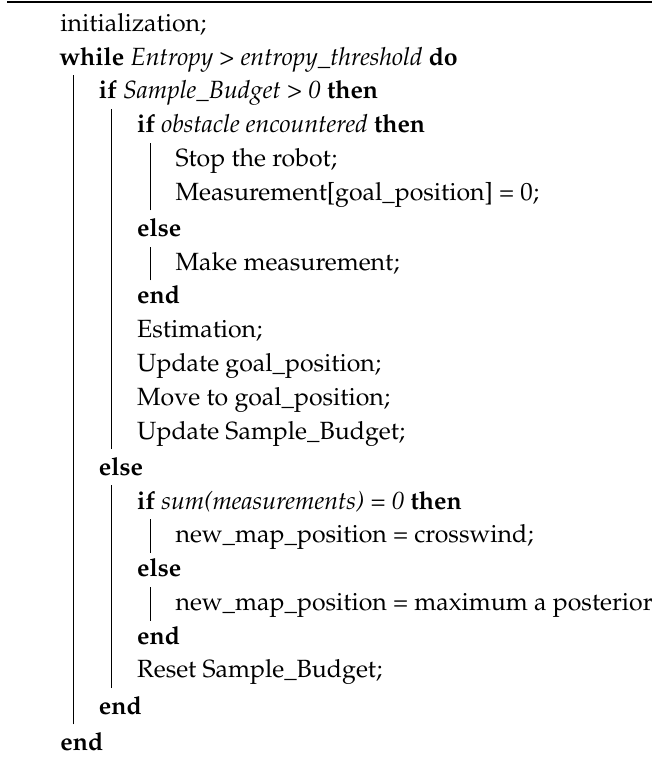
Algorithm 1: Local framework: when and how to change the position of the local